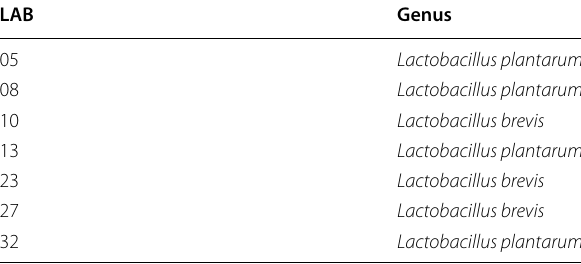
Table 3 The genus of 7